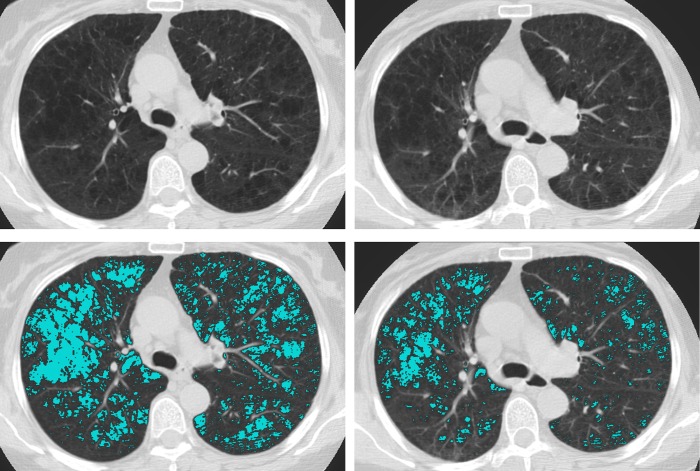
Screenshots of a negative emphysema score progression case.Four screenshots with emphysema score overlays from one participant are displayed. The left-side screenshots are from the baseline scan; the right-side screenshots are from the first annual follow-up scan. The top screenshots are without the emphysema score overlay. This participant had an emphysema score progression rate of -10.3.